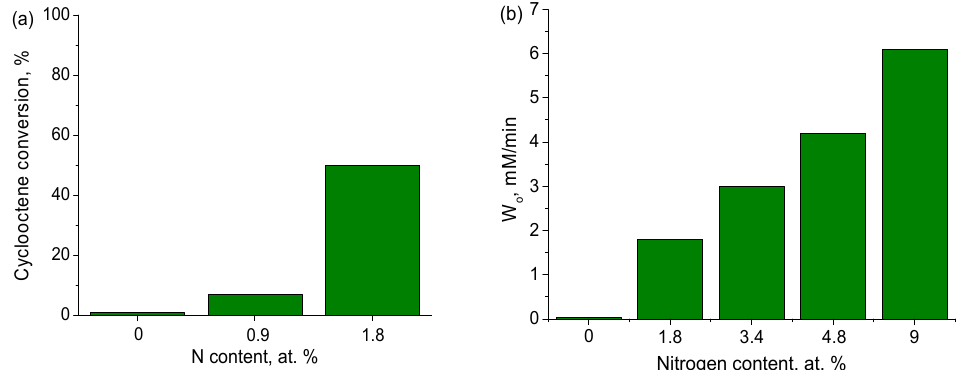
Figure 9. Effect of N content in N-CNTs on ( a ) cyclooctene conversion in the oxidation with H 2 O 2 over N-CNTs ([CyO] = 0.1 M, [H 2 O 2 ] = 0.1 M, 10 mg of N-CNTs, 5 mL CH 3 CN, 4 h, 50 °C) and ( b ) initial rate (W 0 ) of H 2 O 2 decomposition in the absence of organic substrate ([H 2 O 2 ] = 0.11 M, 10 mg N-CNTs, 5 mL CH 3 CN, 50 °C).